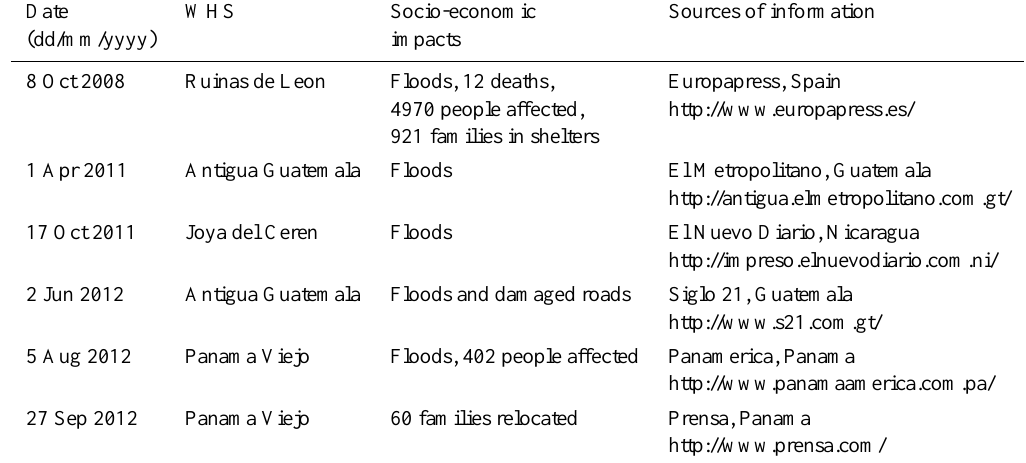
Table 1. World Heritage Sites in Central America impacted by environmental phenomena during 2008–2012 (last access: 21 July